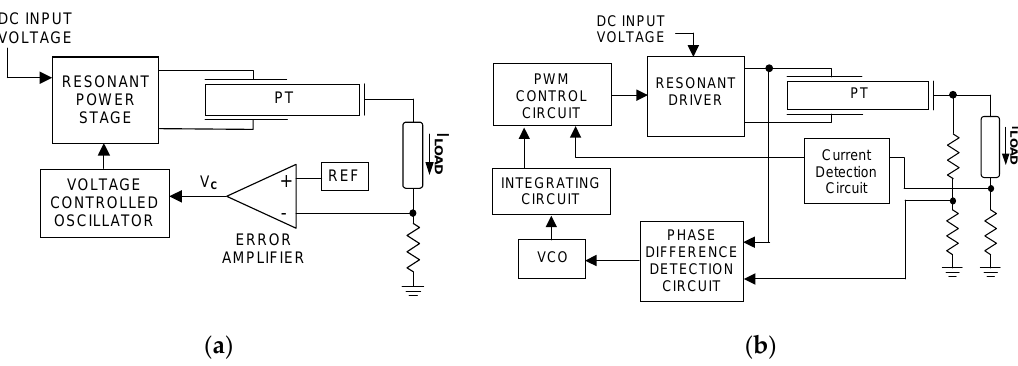
Figure 11. Different tracking control schemes for piezoelectric transformers: ( a ) based on measuring the output current; ( b ) based on the input to output phase difference.